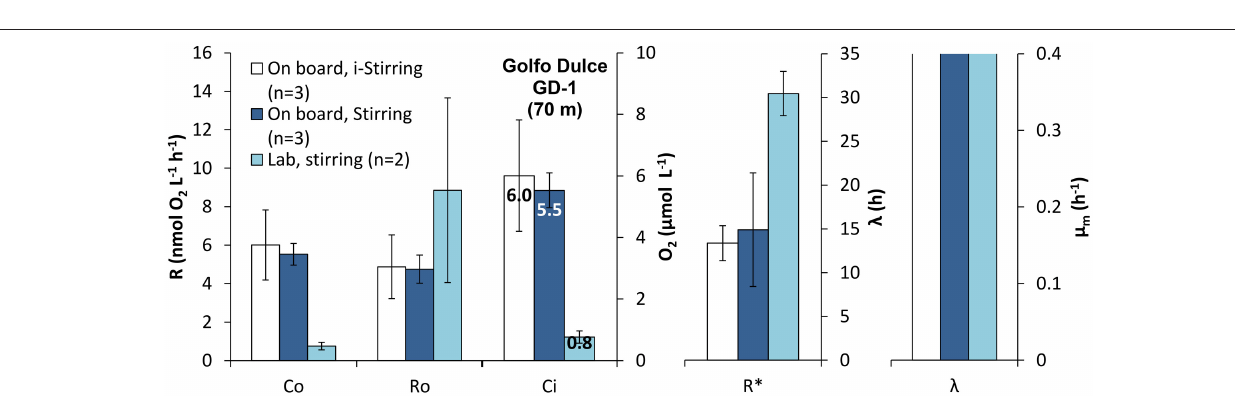
for other microbial aerobic or anaerobic processes such as nitrite oxidation, reduction of nitrate to nitrite and